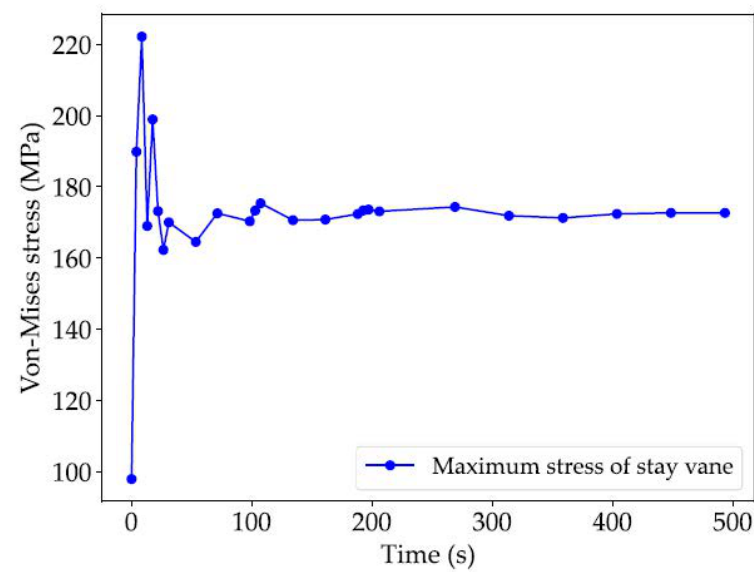
Figure 19. The maximum stress of the stay vane during turbine start-up.